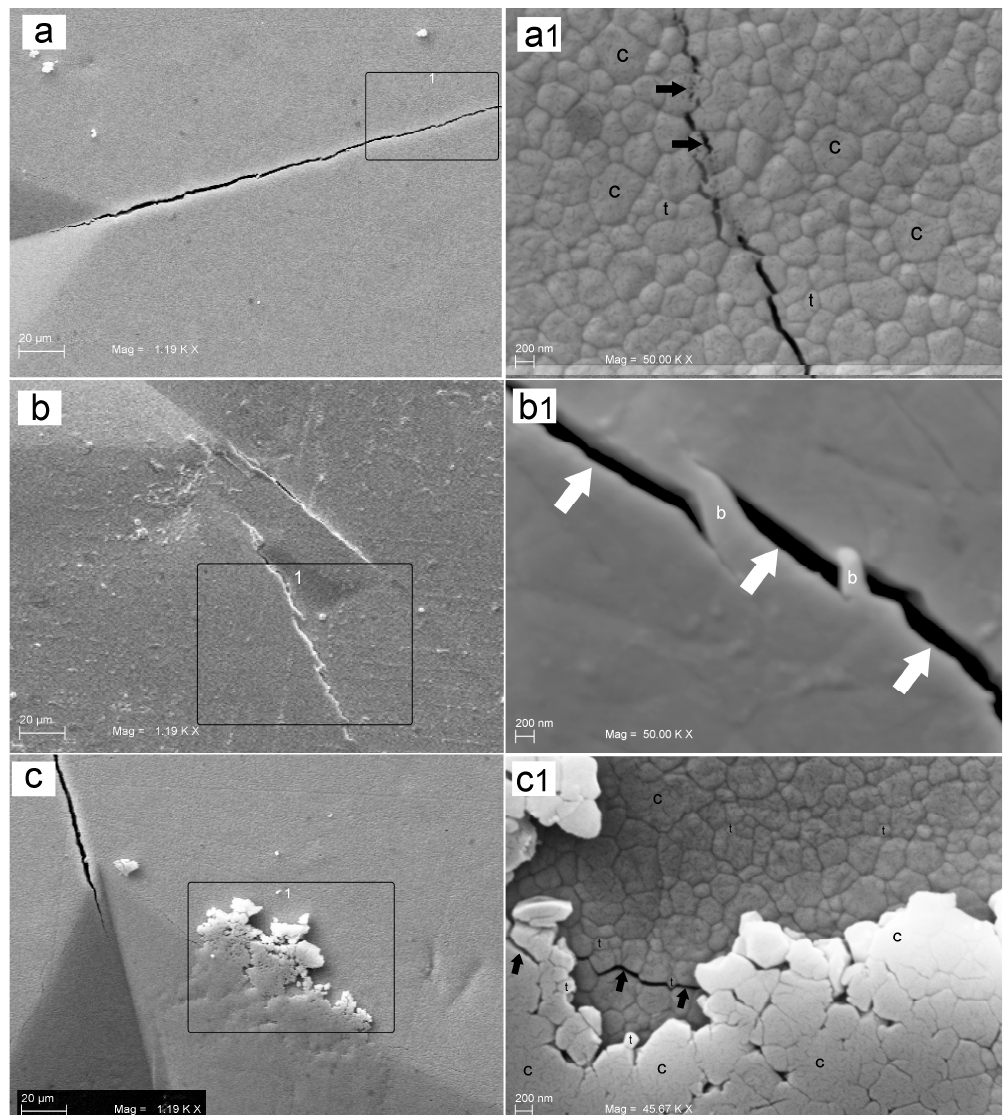
Figure 7. SEM images showing the microcrack propagation; ( a ) group A at low magnification (1190 × ). The rectangle delimits the area reported in ( a1 ); ( a1 ) at higher magnification (50,000 × ), the relationship between grains and microcracks appears. The black arrows indicate a trans-granular fracture near the crack tip. It is also possible to recognize cubic grains (C) and tetragonal grains (t) on the basis of their dimensions. ( b ) Group B at low magnification (1190 × ). The rectangle delimits the area reported in ( b1 ); ( b1 ) at higher magnification (50,000 × ), the “bridging” phenomena (b) along the margins of microcracks (white arrows) highlight the effects that tend to close the fracture line, since the conventional zirconia undergoes a phase shift (tetragonal vs. monoclinic structure) with a crack tip closure phenomenon; ( c ) group C at low magnification (1190 × ). The rectangle delimits the area reported in ( c1 ); ( c1 ) at higher magnification (50,000 × ), a different relationship between grains and microcracks appears after the aging process. The black arrows indicate an intergranular fracture development (at grain boundaries) that shows a faster microcrack propagation. It is also possible to recognize cubic grains (C) and tetragonal grains (t) on the basis of their